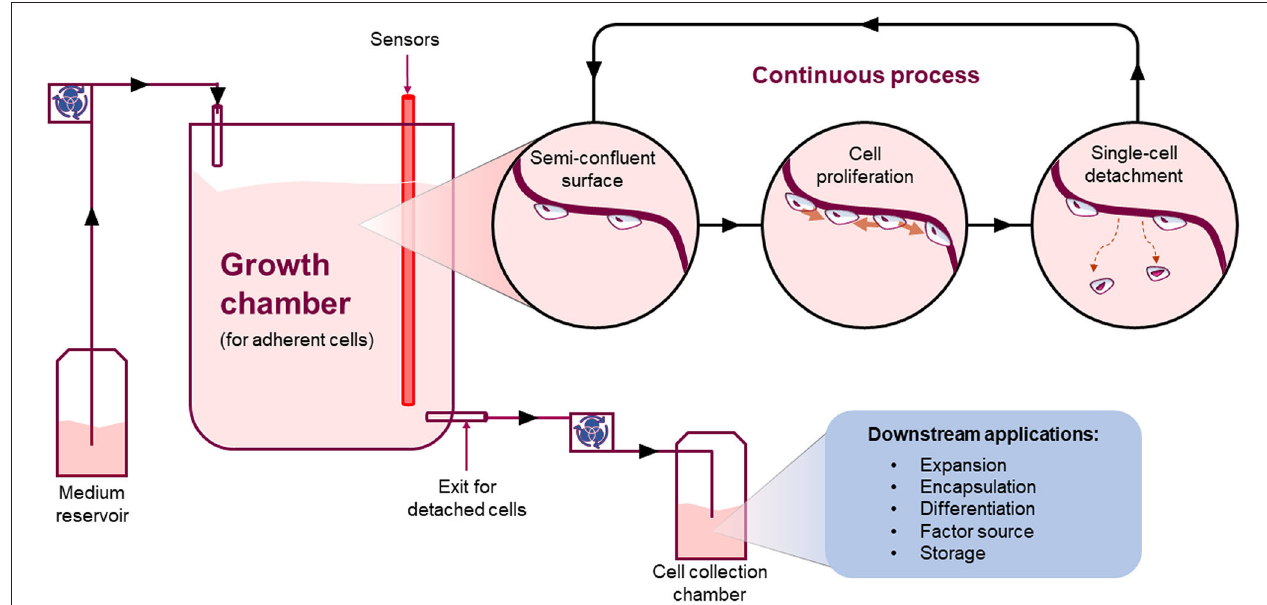
FIGURE 7 | Continuous process. Schematic showing an example of how a continuous process for the manufacture of adherent cells could work. Such system will allow adherent cells to grow onto a surface and detach continuously as single-cells at a steady-state. The detaching cells will leave an empty space for neighboring cells to grow into maintaining a stable number of cells in culture whilst continuously harvesting single cells from the system.